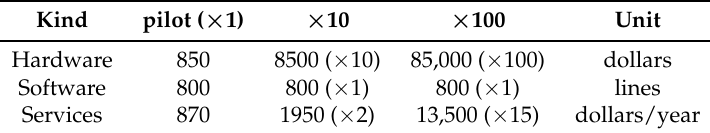
Table 2. Scale-up with scale factors × 1 (pilot), × 10 and ×